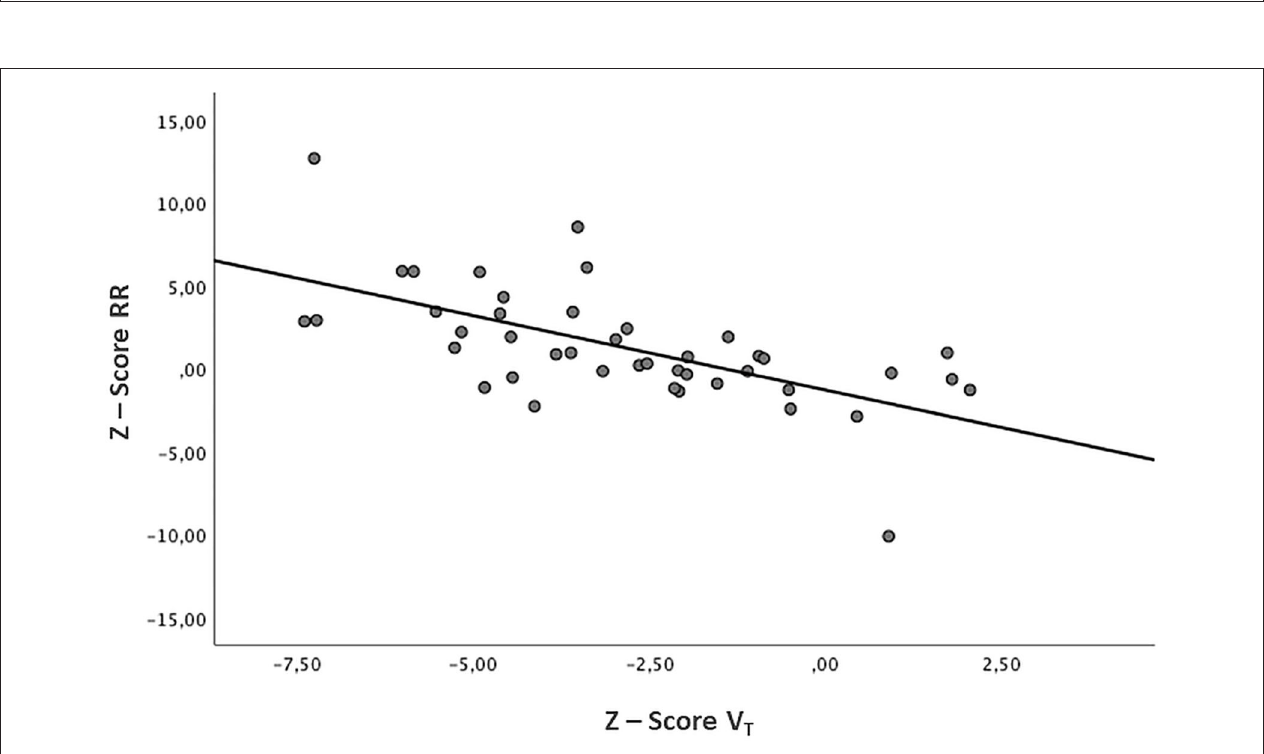
Frontiers in Pediatrics |